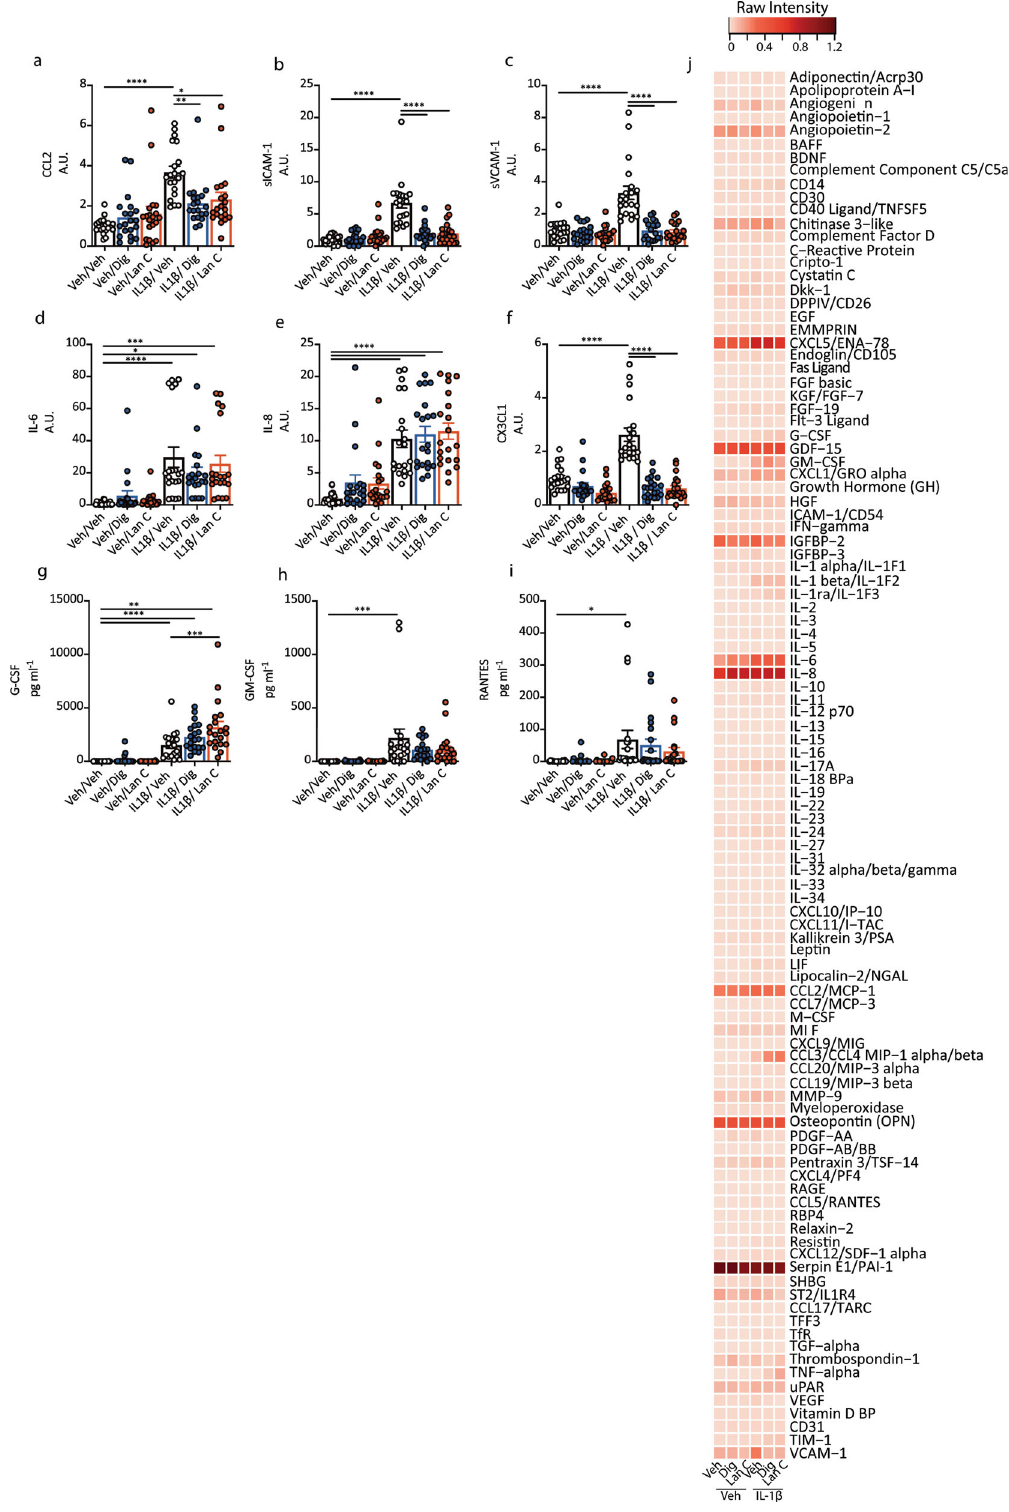
Fig. 6 Cardiac glycosides modulate in fl ammatory responses in leptomeningeal explant cultures. a – i Meningeal explants were pretreated with vehicle (white bars), digoxin (blue bars) or lanatoside C (red bars) for 24 h then treated vehicle or IL-1 β for 24 h. Secretions were measured using CBA ( n = 3 – 5 explants per condition, 5 cases: H253, FTD6, HC166, PD85, AZ133). Secretions in pg mL − 1 were normalised to vehicle for each case-arbitrary units (A.U.) except for G-CSF, GM-CSF and RANTES where cytokines were below the detection level in vehicle conditions. Two-way ANOVA with Tukey ’ s multiple comparison test, mean ± SEM. **** p < 0.0001, *** p < 0.001, ** p < 0.01, * p < 0.05. j Proteome pro fi lers were used to characterise LME secretions in response to vehicle or IL-1 β (10 ng mL − 1 ) with either digoxin or lanatoside C pre-treatment (10 µ M). Average intensity values from proteome pro fi lers were normalised to the reference spots on each blot (heatmap is average of n = 3 cases used: FTD6, HC166, PD85, each pooled from 3 – 4 explants per